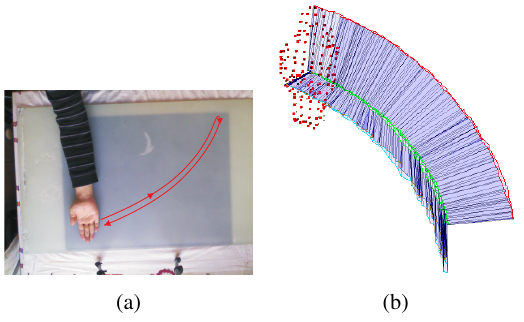
Figure 11: Tracking a palm (152 frames). (a) is a waving sce- nario of a palm. (b) is the 3D demonstration of the palm cloud, trajectory of a control vector from palm centroid (green) to fin- gertip (red), and the normal vector of the palm plane through the centroid with 10 mm length (from green to cyan).